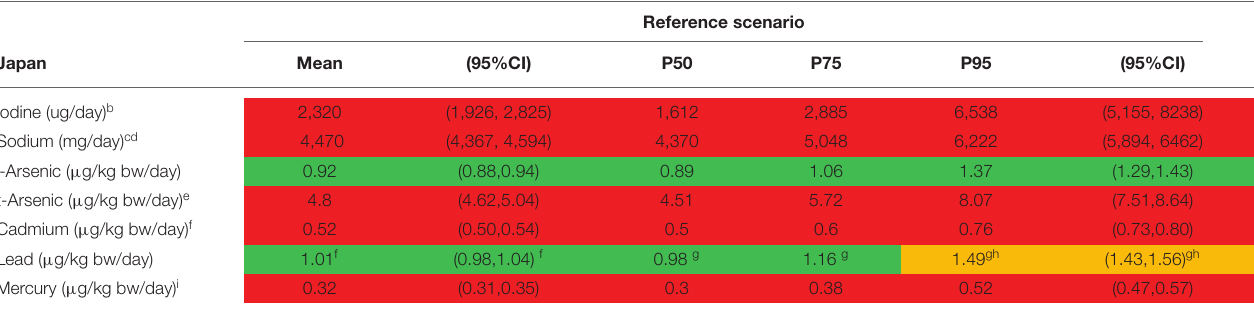
TABLE 7 | Outcome of the assessment for the intake of selected nutrients (iodine and sodium) and exposure to contaminants (arsenic, cadmium, lead, and mercury) for Japan a .